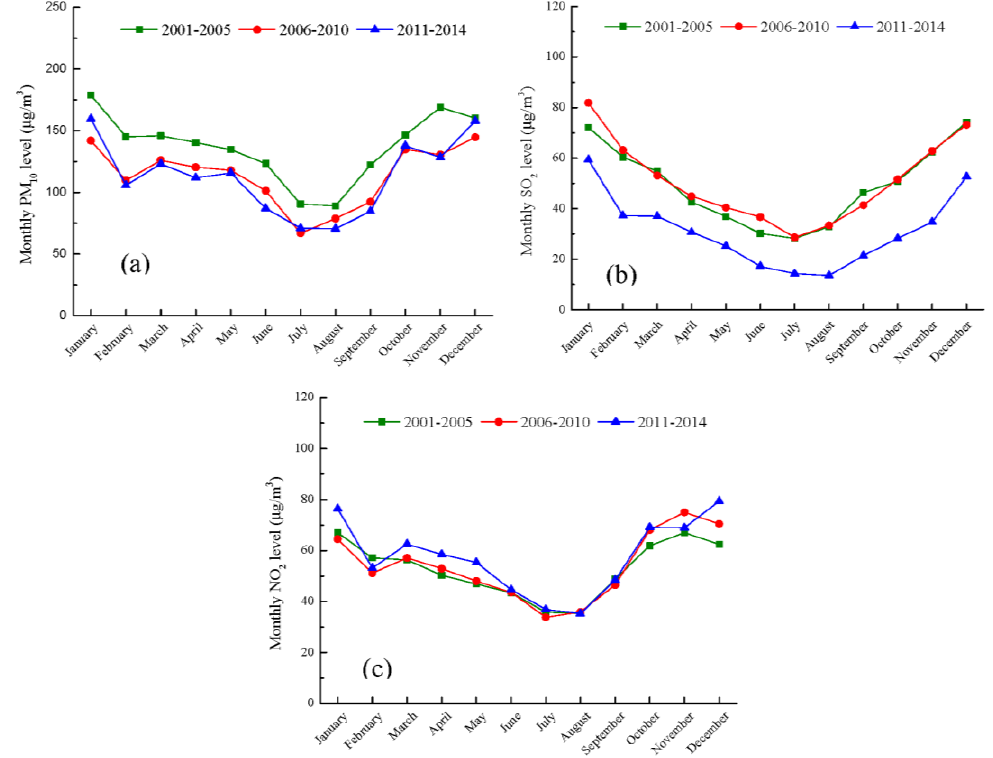
Figure 6. Monthly variation of air pollutant levels of ( a ) PM 10 ; ( b ) SO 2 ; ( c ) NO 2 .